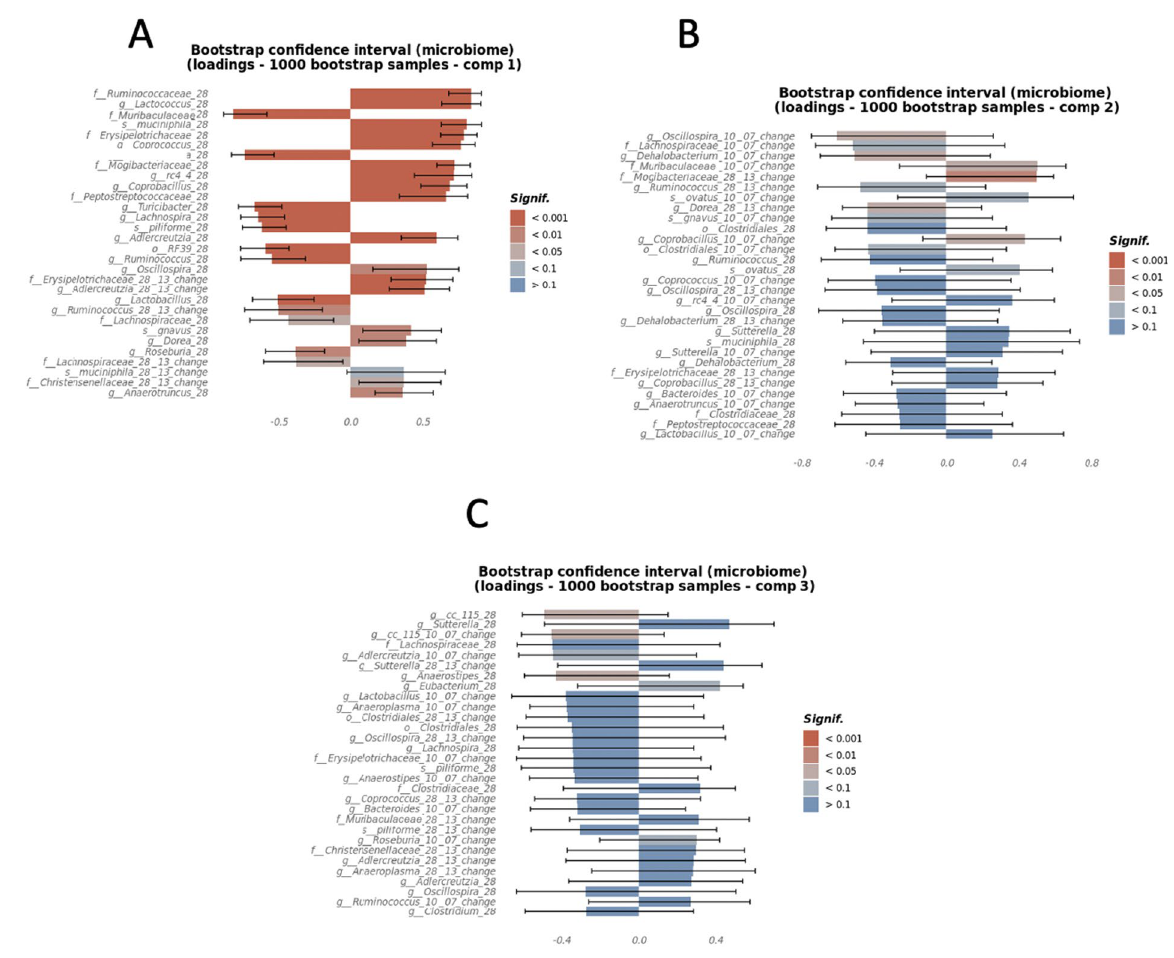
Figure 7. HFD, estradiol and cohouse-induced changes in gut microbiota correlate with anxiety behavior. Canonical loadings of bacterial OTUs of the top 3 canonical components that were associated with diet, estradiol treatment, and/or cohousing, respectively, and were correlated with components of anxiety behavior derived using individual anxiety measures from the Open Field, Light–Dark, and Elevated Plus Maze tests. ( A ) Canonical loadings of microbial taxa that correlated with the 1st canonical component. ( B , C ) Canonical loadings of microbes that were correlated with the 2nd and 3rd canonical components of anxiety (n = 8/ group). Color gradings depict the statistical significance levels of canonical loadings and whiskers show 95% CI (mean + SEM) which measure the significance and stability of the block-weight vectors on 1000 bootstrap samples. The direction (+/−) of canonical loadings depict the direction (+/−) of variable (anxiety, microbiome, treatment) correlations with canonical variates (anxiety, microbiome,